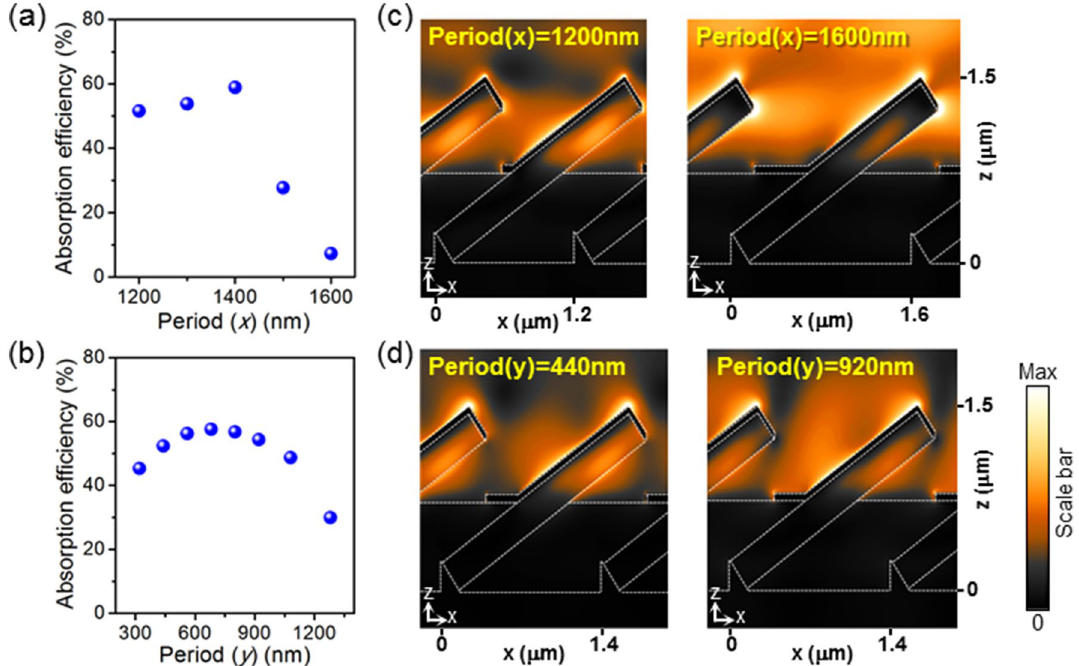
Figure 3. Effect of periodicity of nanowire array. ( a ) Absorption efficiency as a function of periodicity along the x -direction and ( b ) y -direction. ( c ) Electric field profiles (| E |) when periodicity along the x -direction and ( d ) y -direction is